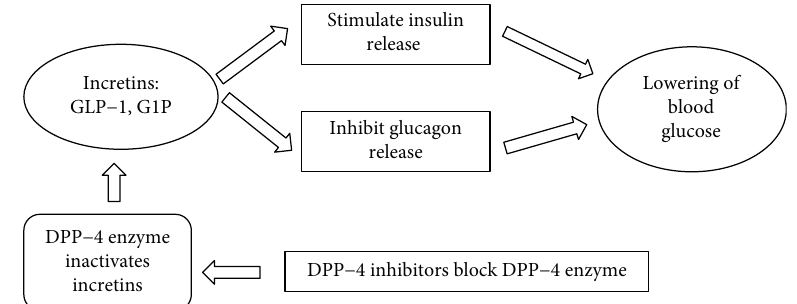
Figure 1: Action of DPP-4 inhibitors on glucose